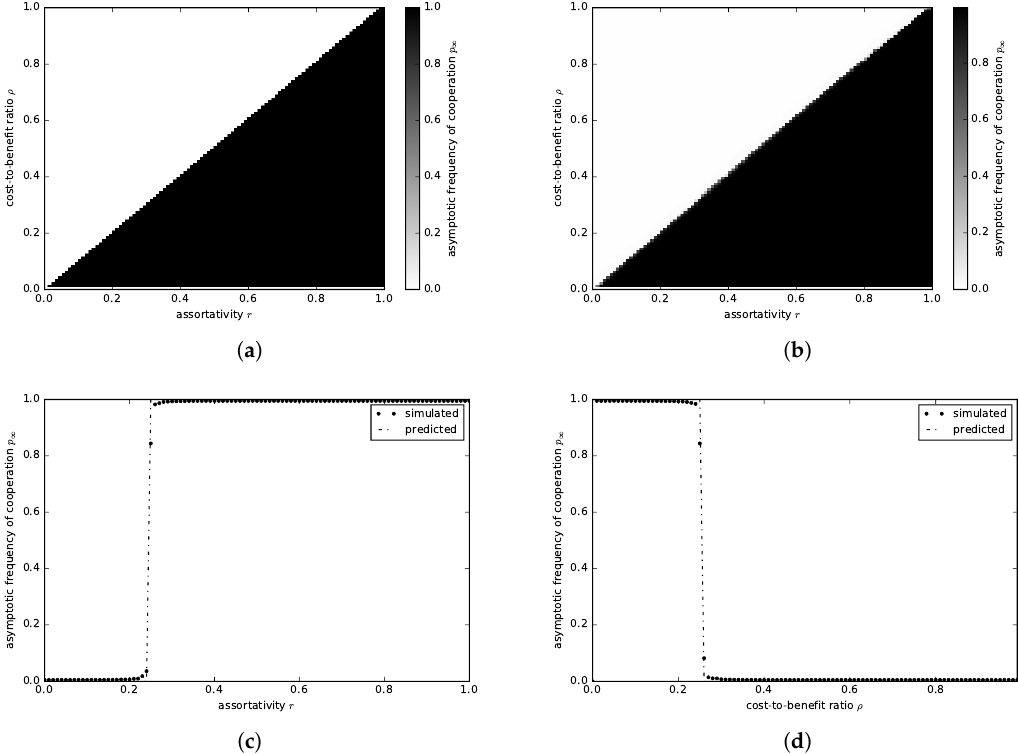
Figure 4. Variation of the long-term frequency p ∞ of cooperators with assortativity r ∈ [ 0,1 ] and cost-to-benefit ratio ρ ∈ ( 0,1 ) for the donation game. ( a ) p ∞ (analytically predicted) versus r and ρ . ( b ) p ∞ (simulated) versus r and ρ . ( c ) p ∞ versus r when ρ = 0.25. ( d ) p ∞ versus ρ when r = 0.25. Parameters: n = 10,000, p 0 = 0.5, and β =